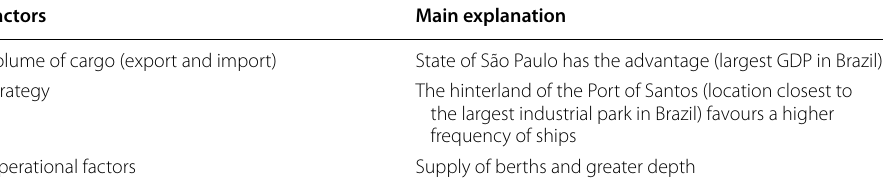
Table 5 Factors most highlighted by shipping lines Factors Volume of cargo (export and